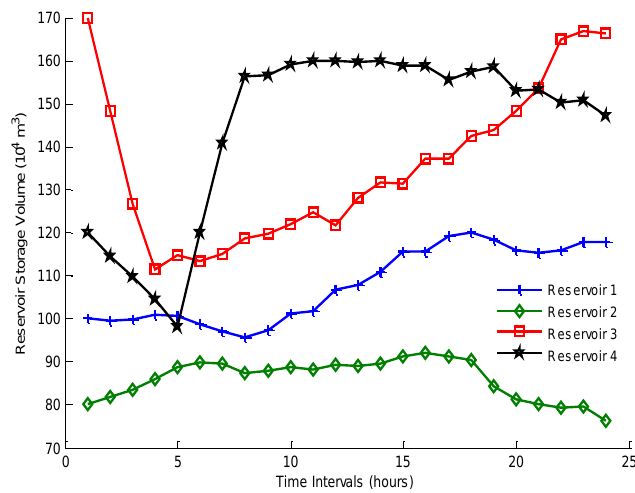
Figure 6. Hydro reservoir storage volumes with NSDOGSA for MSHTS of Test system-II.